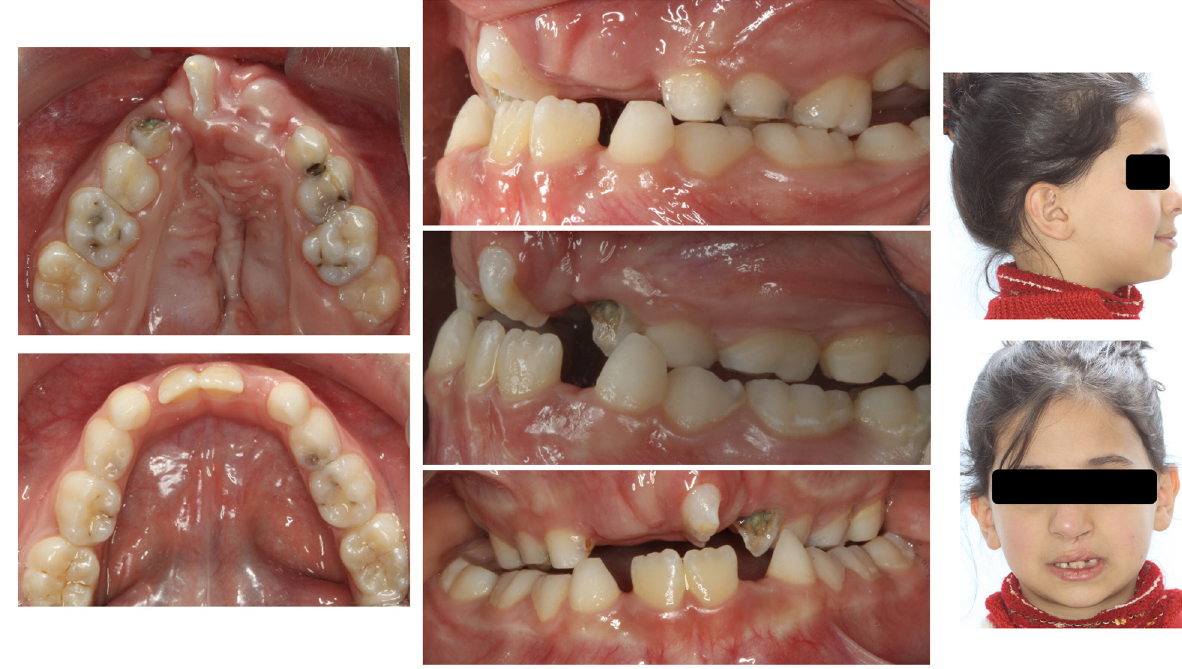
Figure 3. Front view of lips, nose, and mouth at 8 years old.